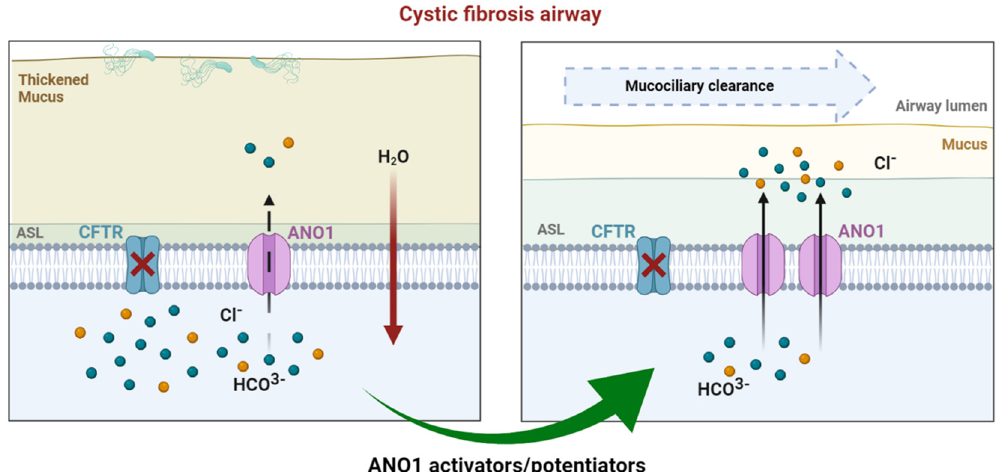
Figure 3. In CF airways, dysfunctional CFTR leads to compromised chloride efflux. Sodium entry is upregulated, leading to a dehydrated air surface liquid (ASL) and impaired mucociliary clearance favoring mucostasis, causing chronic inflam- mation and infection. In healthy airways, ANO1 is colocalized with CFTR within the apical membrane of epithelial cells, contributing to ion and water homeostasis. In CF ciliated cells, the expression of ANO1 is also diminished. Modulating ANO1, as an alternative CF therapy, could compensate for defective CFTR and, thus, enhance fluid secretion by ciliated epithelial cells, regulating ASL height and